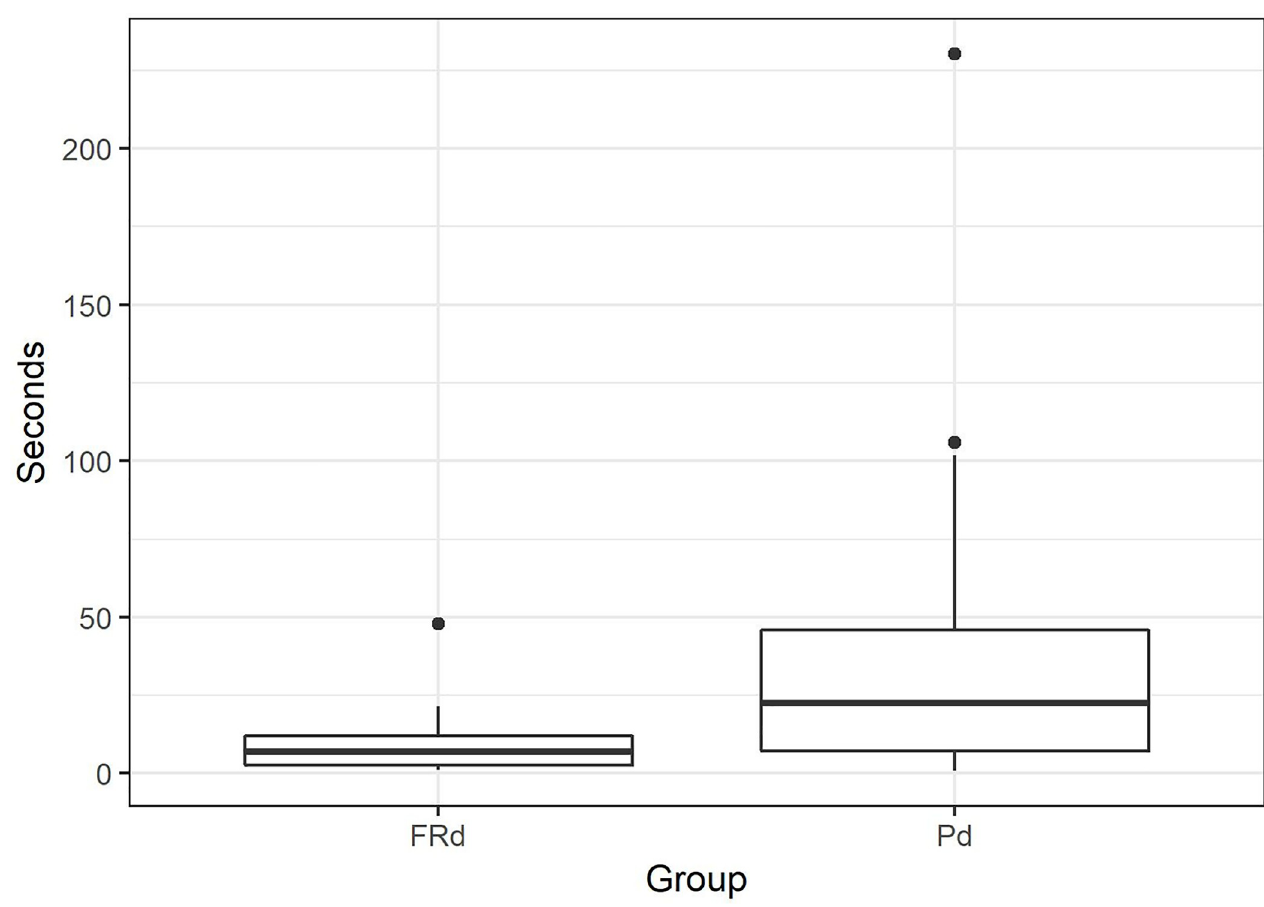
Fig 6. Duration of manipulation of the bottle for free-ranging dogs (FRd) and pet dogs